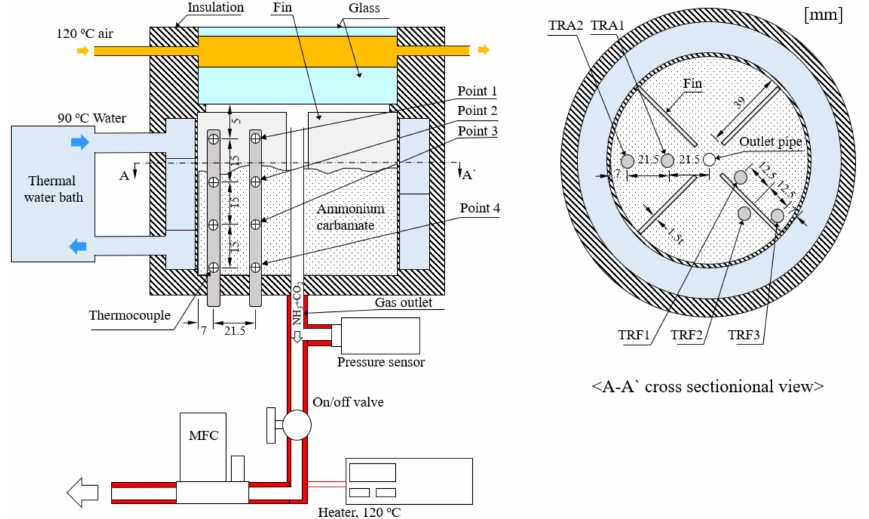
Figure 1. Schematic of experimental set-up for validation of AC sublimation